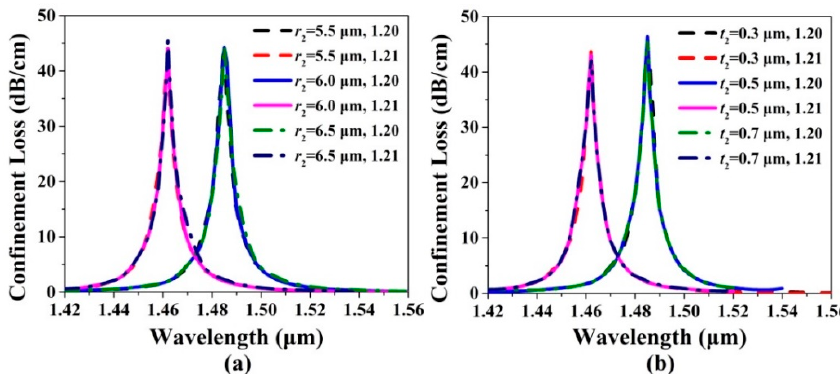
Figure 4. The confinement loss spectra of the x -pol core mode when ( a ) r 2 increases from 5.5 to 6.5 μ m and ( b ) t 2 increases from 0.3 to 0.7 μ m for the RIs of the filled analyte of 1.20 and 1.21, respectively.